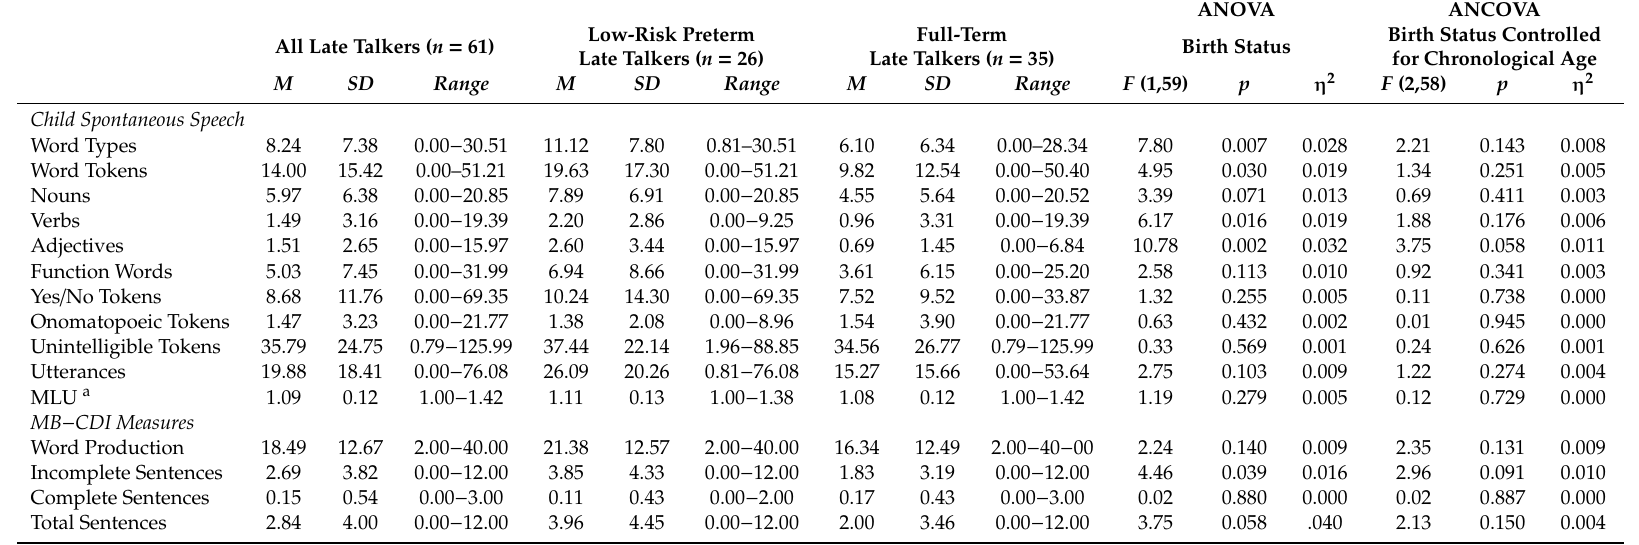
Table 2. Descriptive data for child spontaneous and reported (MB-CDI Words and Sentences Short Form) speech measures. The table also summarizes the F , p and eta-squared values ( η 2 ) for the ANOVAs and ANCOVAs comparing the child measures of the low-risk preterm and full-term late